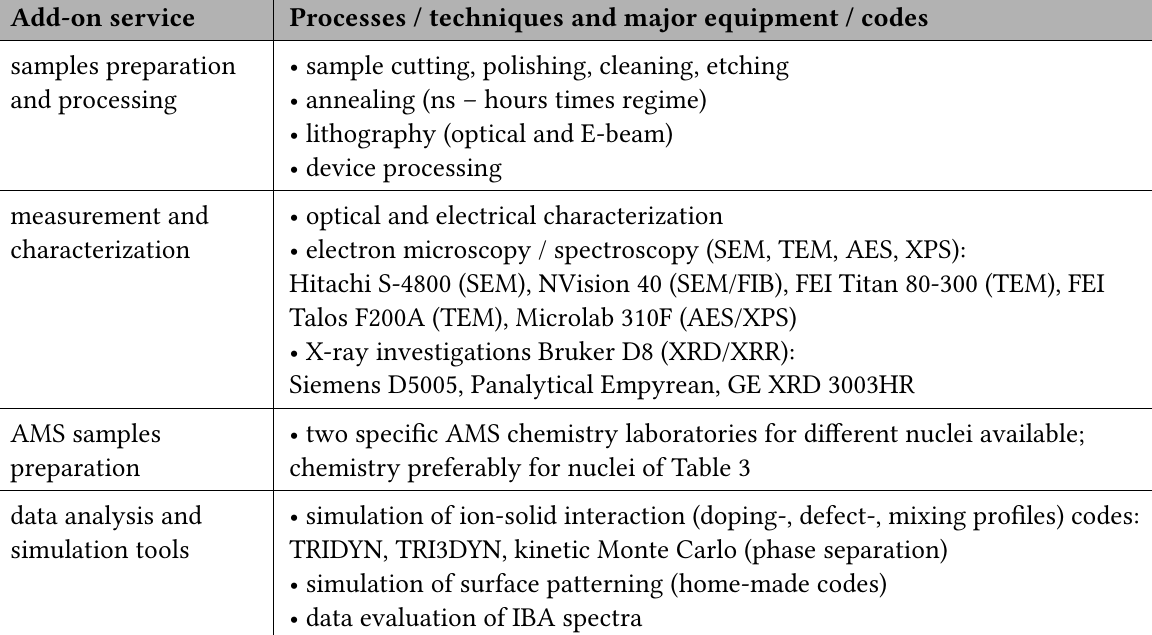
Table 6: Add-on services offered by